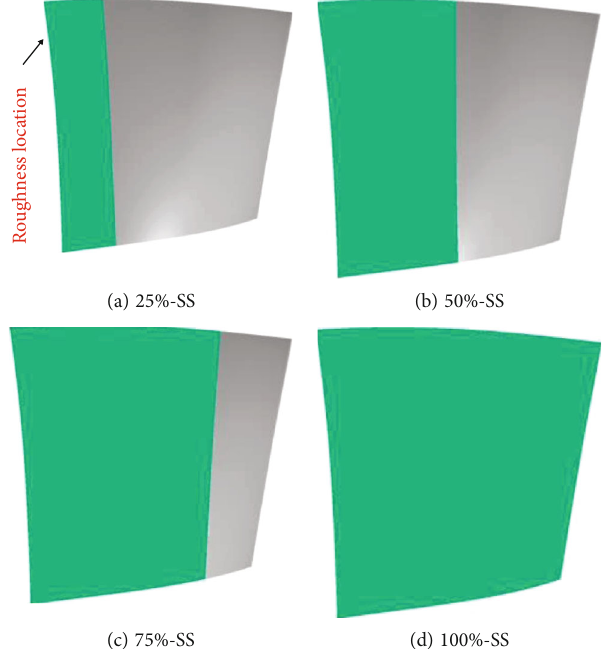
Figure 6: Roughness locations on the suction side of the rotor.